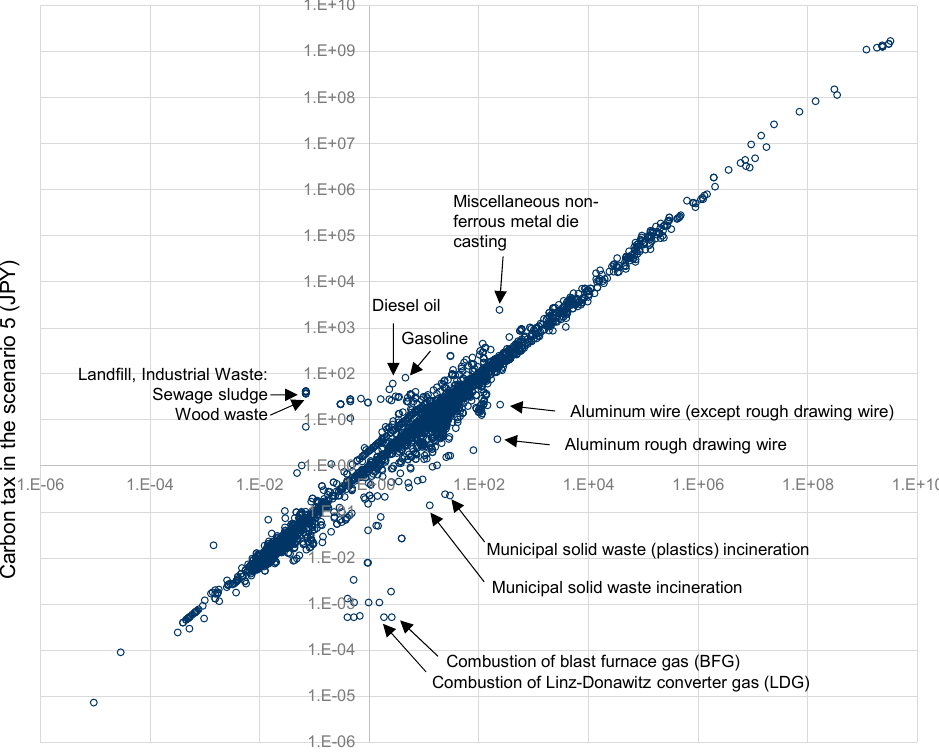
Figure 9. Comparison of the carbon tax in Scenario 5 and the calculated carbon tax based on cumulative CO 2 emissions when the CO 2 price is JPY 10,000. Data are plotted in log-log scale.